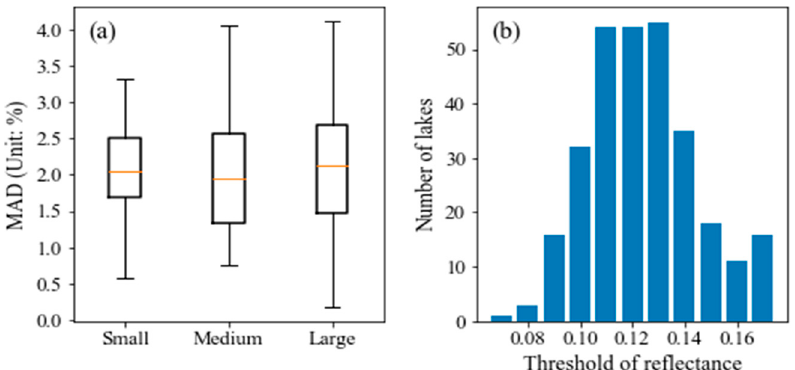
Figure 5. Calibration of MODIS thresholds against lake fraction of Landsat Fmask. ( a ) is the mean absolute distance (MAD) between MODIS and Fmask lake ice fraction calculated using the optimal thresholds. Lakes are divided into three groups by size. ( b ) is the distribution of optimal thresholds selected by all lakes.